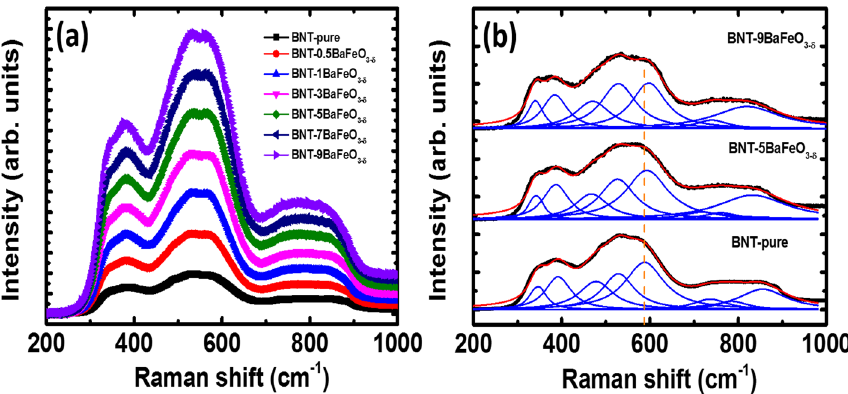
Figure 4. (a) Raman scattering spectra of BaFeO 3− δ solid solution into Na 0.5 Bi 0.5 TiO 3 with various concentrations from 200 cm −1 to 1000 cm −1 ; and (b) deconvolution Raman peaks of pure Na 0.5 Bi 0.5 TiO 3 and 5 and 9 mol% BaFeO 3− δ solid solution into Na 0.5 Bi 0.5 TiO 3 .